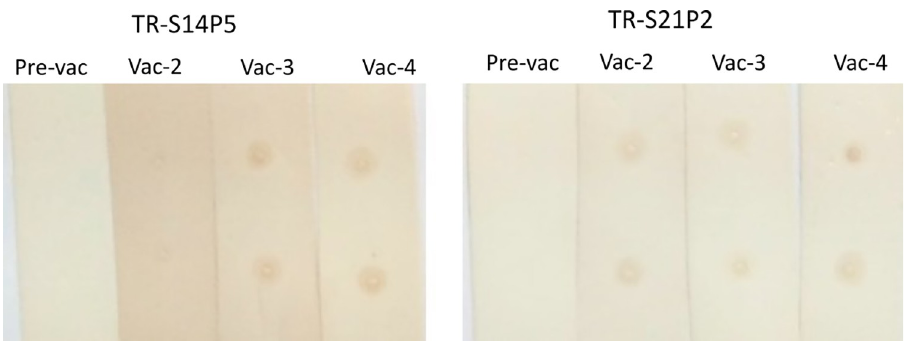
Fig 5. Dot-blot assay to show specific recognition of formaldehyde-inactivated SARS CoV-2 (SARS-CoV-2/ human/IDN/RSDS-RCVTD-UNAIR-35-B/2020) by sera from rabbits before and after the second third and fourth immunization with recombinant TR-S14P5 or TR-21P2. immunization. A further increase in the titer was still observed after the third immunization with the TR-S14P5 but to a lower degree with the TR-S21P2. The fourth immunization did not or resulted in only a slight increase in the antibody titers. The sera from rabbits immunized with the TR-S14P5 or TR-S21P2 recognized specifically SARS CoV-2 virus. Inactivated SARS CoV-2 virus immobilized on nitrocellulose membrane recognized convincingly by sera from rabbits after the third and fourth immunization (Fig 5).